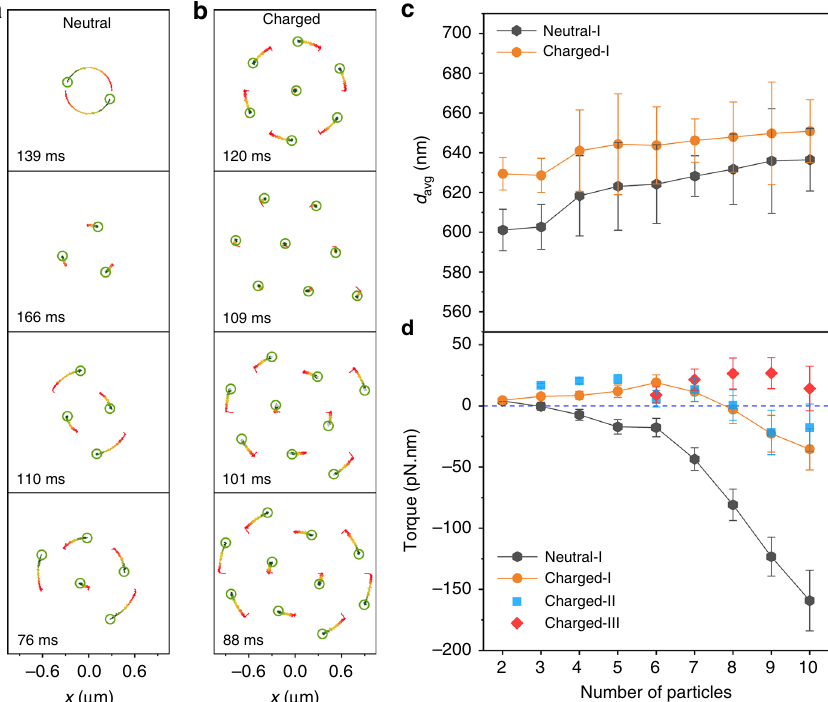
Fig. 4 FDTD-particle dynamics simulation of light-driven self-organization and rotation of mesoscale optical matter arrays. a Rotation of optical matter arrays with neutral NPs governed by optical binding interactions for different numbers of particles in the array. Directions of rotation are indicated by red to green color with open circles showing the fi nal positions of the NPs. The duration of the trajectory is labeled in each panel. b Rotation of optical matter arrays of charged NPs whose structures are determined by both optical binding and electrostatic interactions. c Average nearest neighbor distances ( d avg ) for the arrays with and without added charges. d Calculated optical torques on charged and uncharged arrays. Torque values for type-II and III arrays are also shown for comparison. Data points are mean values with one standard deviation error bars in both c and